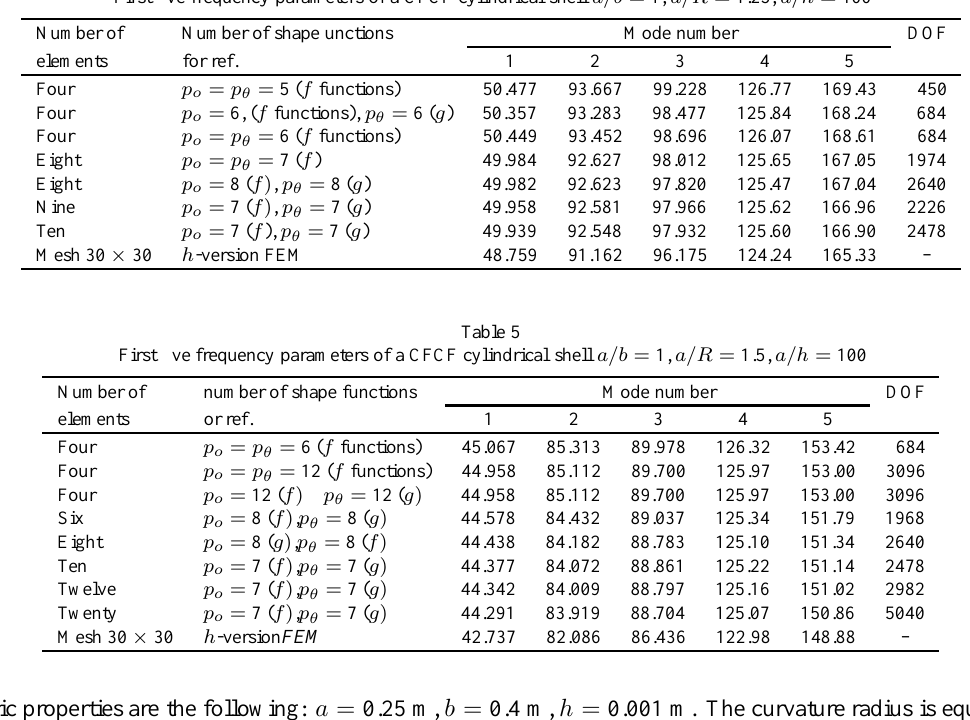
Table 4 First five frequency parameters of a CFCF cylindrical shell a/b = 1, a/R = 1.25, a/h = 100